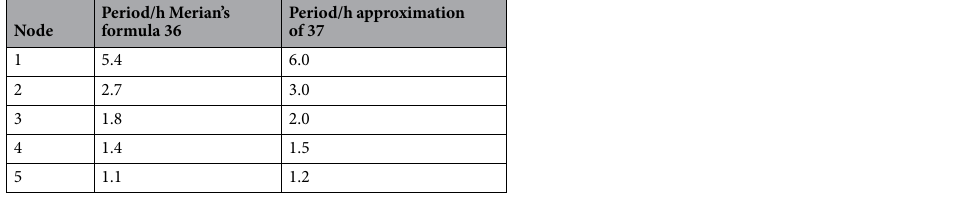
Table 1. Periods of free oscillation modes theoretical in Lake